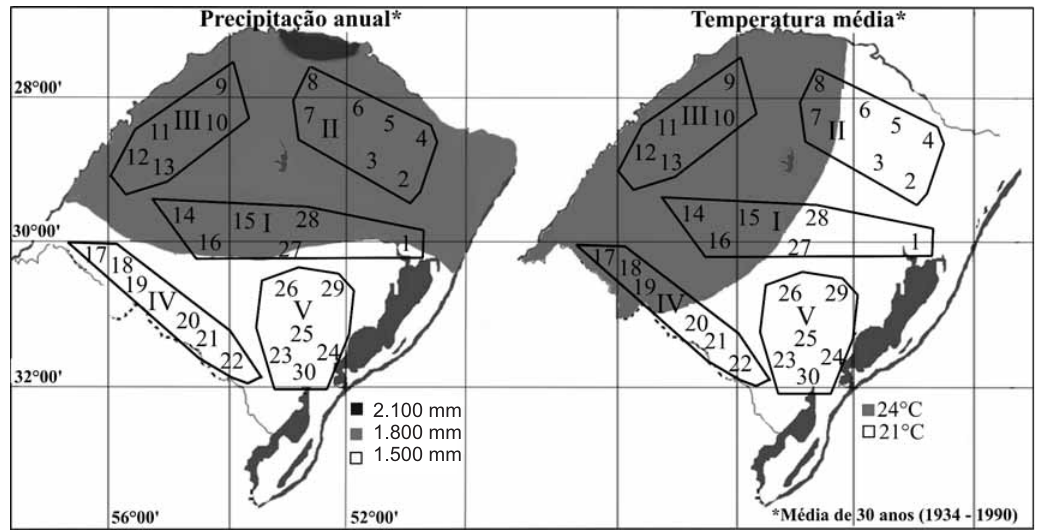
Figura 1. Mapa do Rio Grande do Sul, mostrando as diferenças climáticas e as cinco regiões de amostragem em números romanos (Norte - regiões II e III; Sul – regiões IV e V; Central – região I). Os algarismos arábicos indicam as 30 lavouras onde foram amostradas as plantas de milho utilizadas neste trabalho. As medidas de temperatura média máxima e precipitação anual foram obtidas no oitavo distrito da Rede Regional Meteorológica do Rio Grande do Sul (Instituto de Meteorologia / Ministério da Agricultura). Os valores apresentados representam a média acumulativa dos últimos 30 anos de informação.